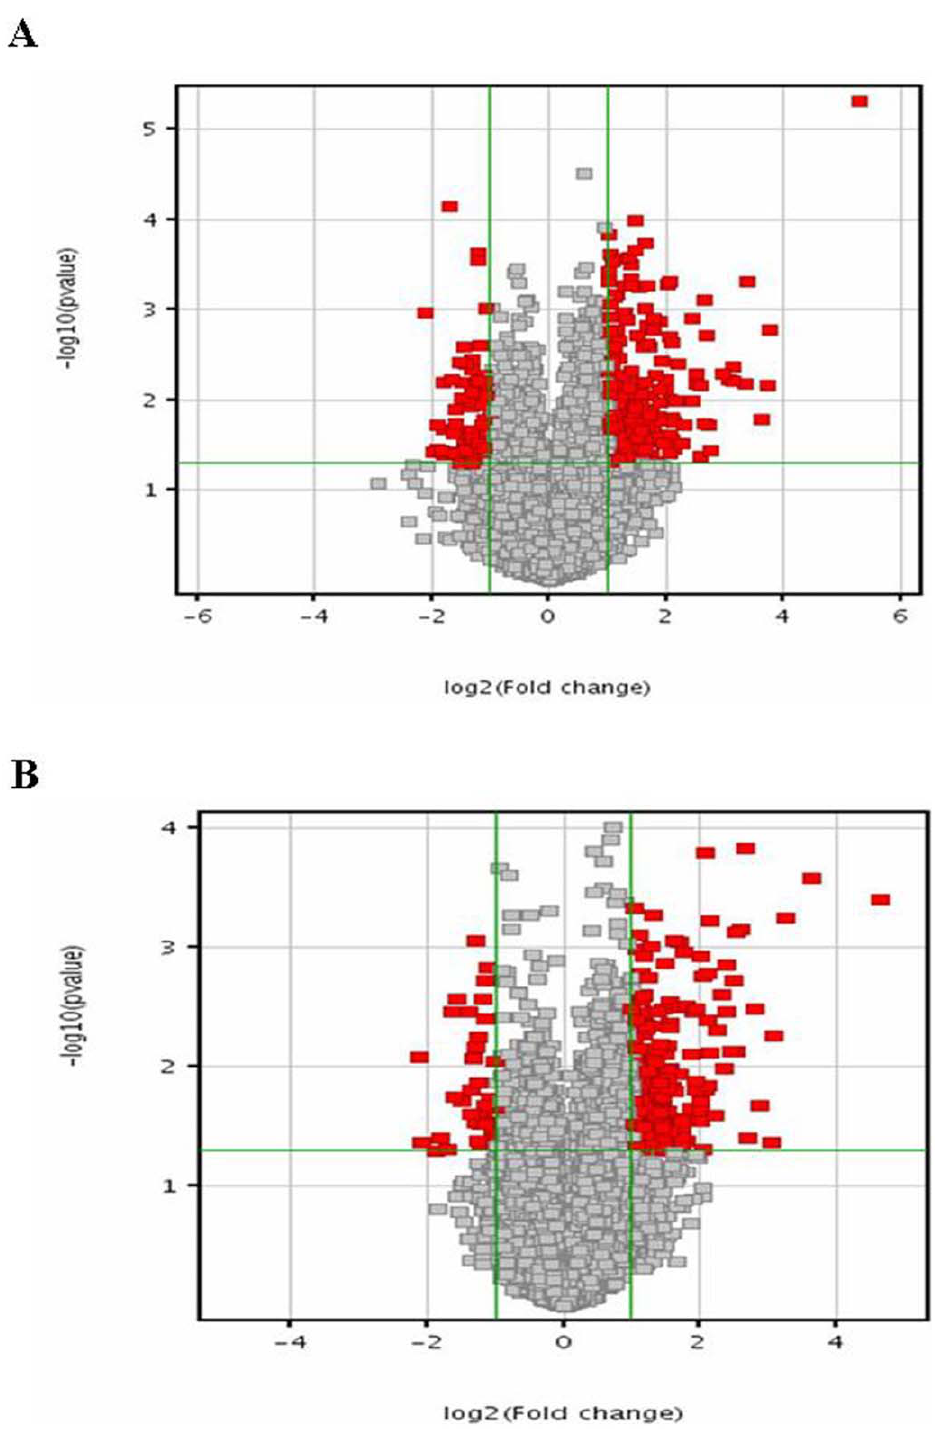
Figure 1. Volcano plot of differentially expressed transcripts. ( A ) Normal untreated vs normal rottlerin-treated fibroblasts. ( B ) SSc untreated vs SSc rottlerin-treated fibroblasts. A volcano plot of genes differentially expressed in human dermal fibroblasts exposed to rottlerin. The X-axis represents the log 2 values of the fold change observed for each transcript whereas the Y axis depicts the log 10 values of the p value of the significance tests between replicates for each transcript. Genes that demonstrate a 2 fold or greater difference in expression at a p value , 0.05 in rottlerin treated cells compared to untreated cells are displayed in red. Dots representing genes of interest validated by RT-PCR are labeled.